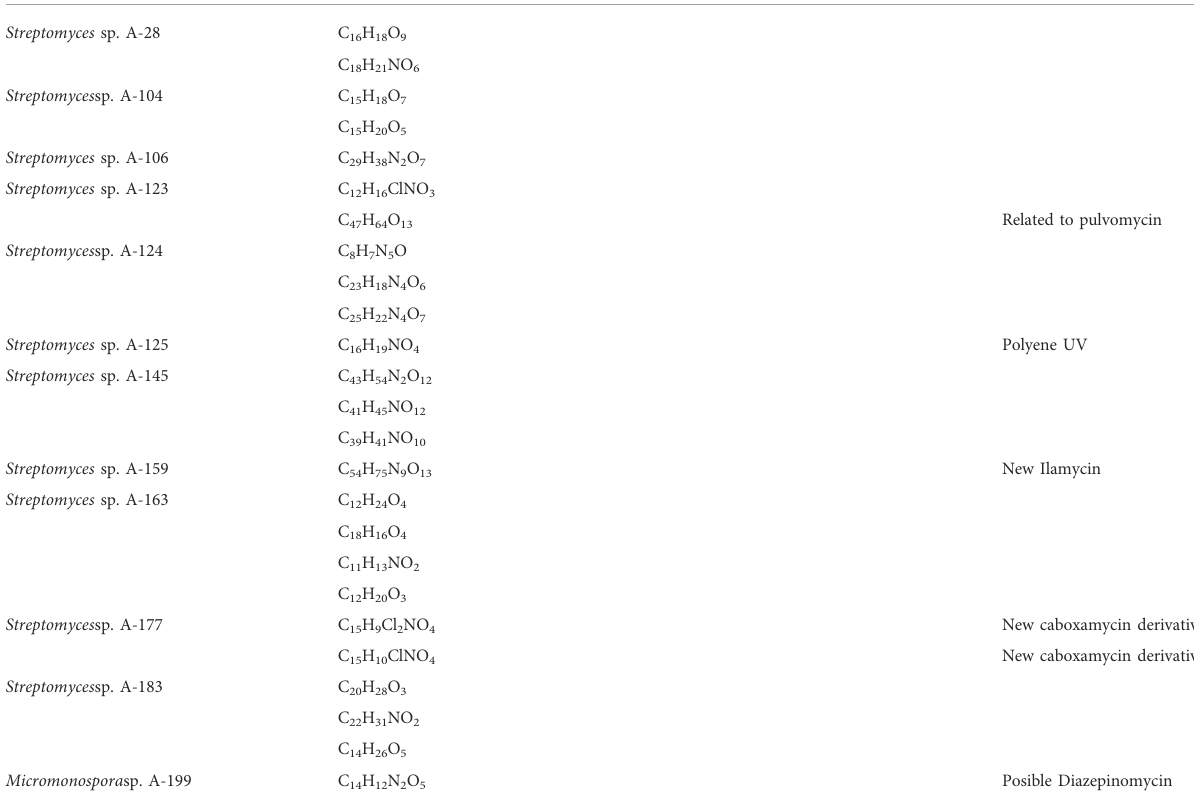
TABLE 4 Molecular formulae of secondary metabolites not previously found in the Dictionary of natural products. Strain Molecular formula of Compounds unmatched in